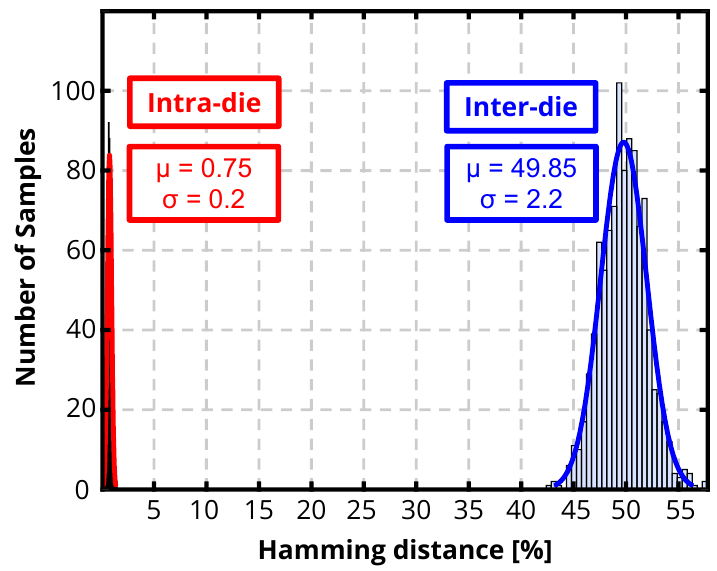
Figure 12. Inter- and intra-PUF Hamming distances in nominal conditions. Table 2. Performance summary and comparison in the FPGA. Slices